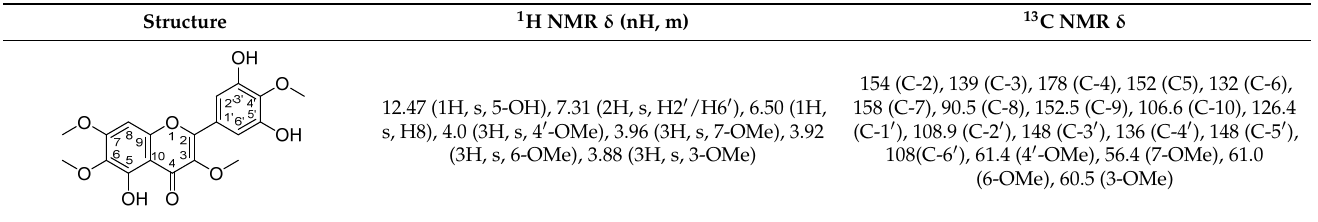
Figure 8. Effect of 2 (1.25, 2.5, 5.0 or 10 µ g/mL) and Ko143 (0.5 µ M) on the colony formation capacity of HT29 SN38 cells, either alone or in combination with 10 nM SN-38 ( A ). Survival fraction (SF) of HT29 SN38 cells when treated with 2 alone or in combination with 10 nM SN-38. Untreated cells were used as controls, ( B ). Colony formation capacity of HT29 PAR untreated cells and cells treated with 10 nM SN-38 ( C ). Data expressed as mean ± SD of n = 3 data points. The data are representative for experiments obtained in three biological replicates. * p ≤ 0.05, ** p ≤ 0.01, *** p ≤ 0.001, ****, p ≤ 0.0001. Table 1. 1 H and 13 C NMR data of 2 . Table 1. 1 H and 13 C NMR data of 2